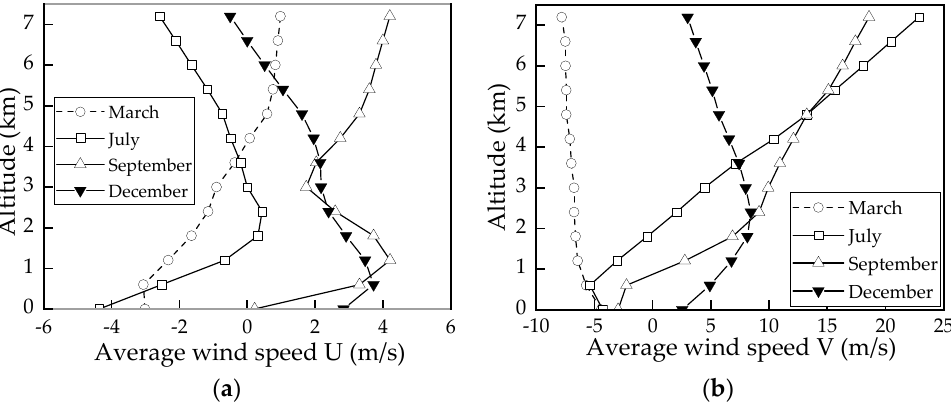
Figure 20. Monthly average wind speed profile of South China Sea (110E, 20N) in 2009.